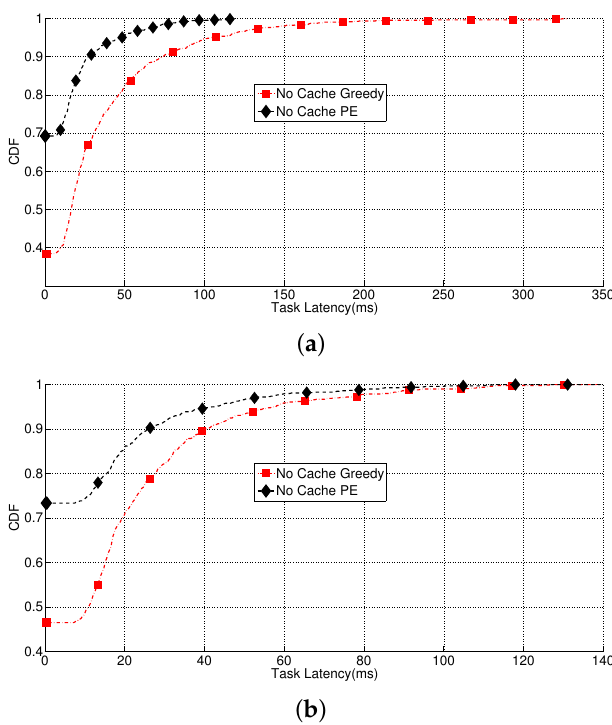
Figure 3. Comparisons of the UE latencies between the PE method and the Greedy method on user task offloading. ( a ): Data-process tasks; ( b ): Data-stream tasks.